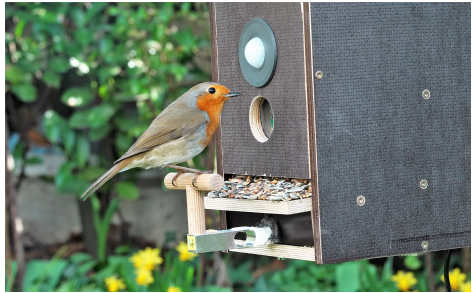
Figure 1. Smart bird feeder visited by a European Robin ( Erithacus rubecula ) © WWU – Simon J¨ocker